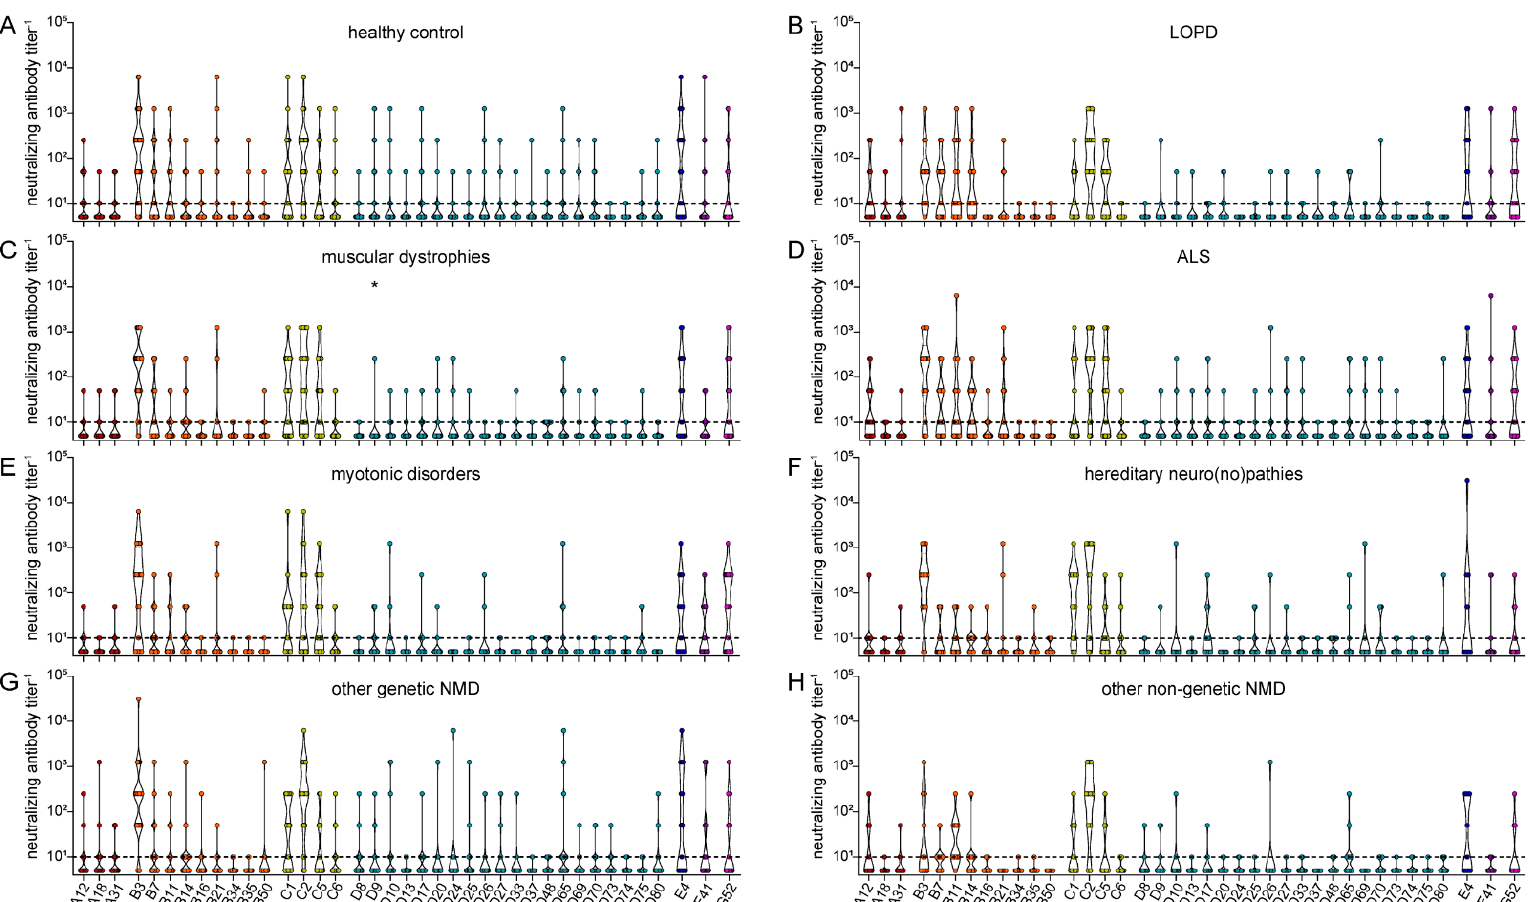
Figure 9. Neutralizing antibody data stratified by health status of serum donors. The data presented in Figure 5 were stratified by the health status of the serum donors, showing data from76 healthy serum donors ( A ), 14 serum donors with LOPD ( B ), 25 serum donors with muscular dystrophies ( C ), 26 serum donors with ALS ( D ), 20 with myotonic disorders ( E ), 13 with hereditary neuro(no)pathies ( F ), 24 with other genetic NMD ( G ) and 11 serum donors with non-genetic NMD ( H ). Each dot represents an individual sample. Significant differences in neutralizing antibody levels compared to the healthy control group are indicated by * ( p < 0.05, Kruskal-Wallis one-way ANOVA on ranks, Dunn´s multiple comparisons test).